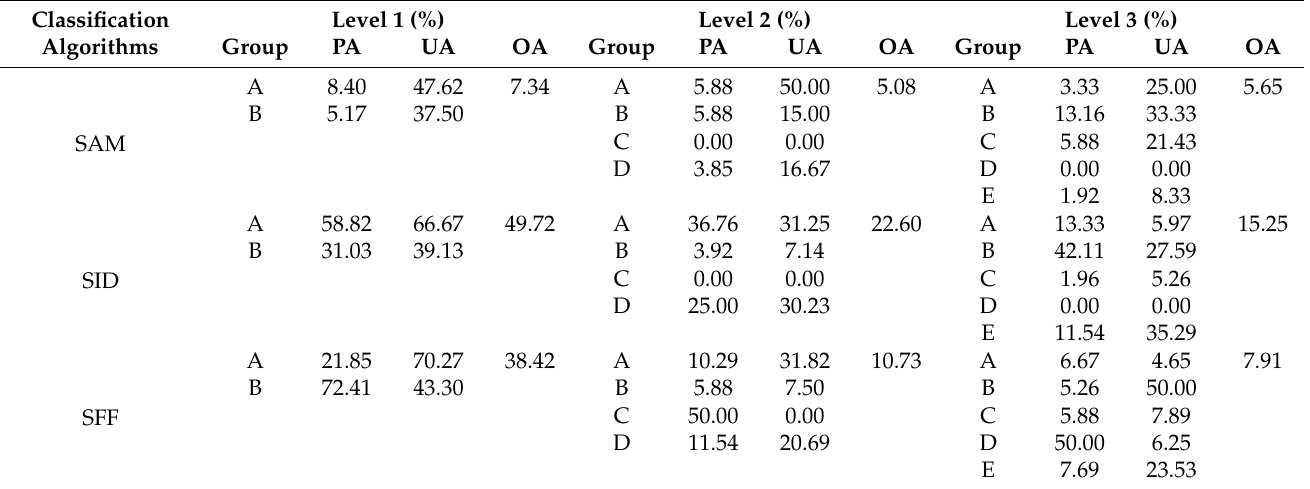
Table 4. Accuracy of mangrove species mapping with SAM, SID, and SFF-based classifications at Levels 1, 2, and 3.